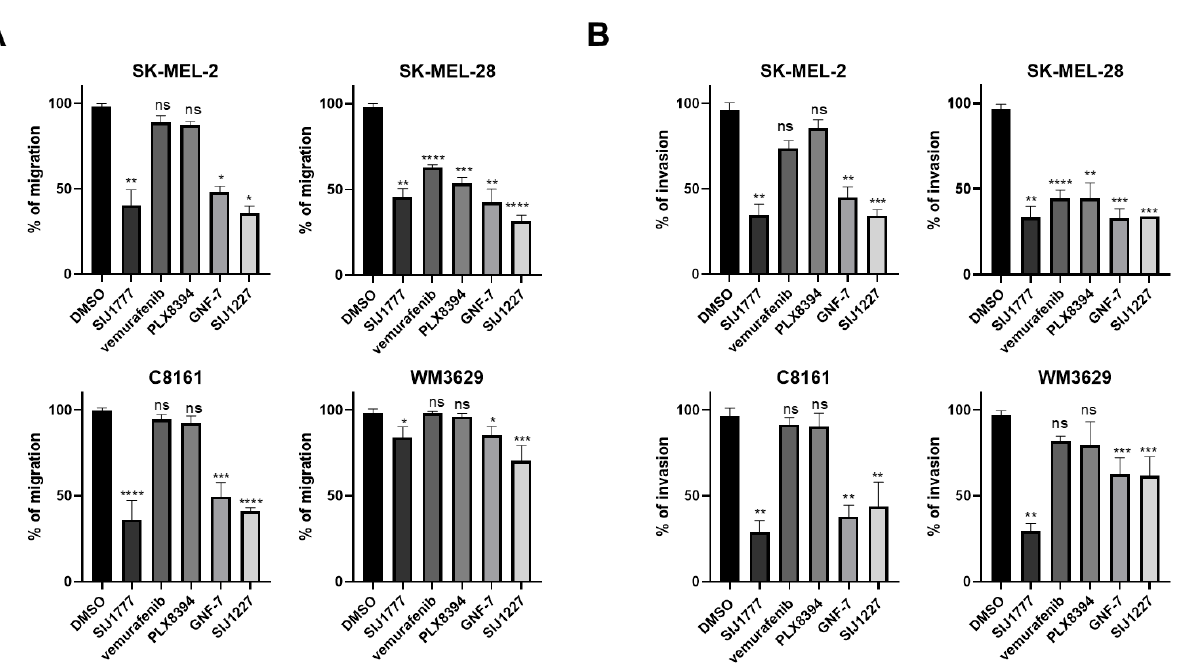
Figure 5. The effect of SIJ1777 on migration and invasion of melanoma cells harboring BRAF wt or class I/II/II mutations. ( A ) Scratch assay results for assessing migration capability. After scratching each cell monolayer, indicated compounds at 0.01 μM concentration were incubated for 12 h. Migration ratio was analyzed using migrated area using ImageJ ( n = 3). ( B ) Boyden chamber assay for assessing invasion capability using cell invasion kit (QCM ECMatrix Cell Invasion Assay, n = 3). Statistical significances were determined using a one-way ANOVA analysis (* p < 0.05, ** p < 0.01, *** p < 0.001, **** p < 0.0001).